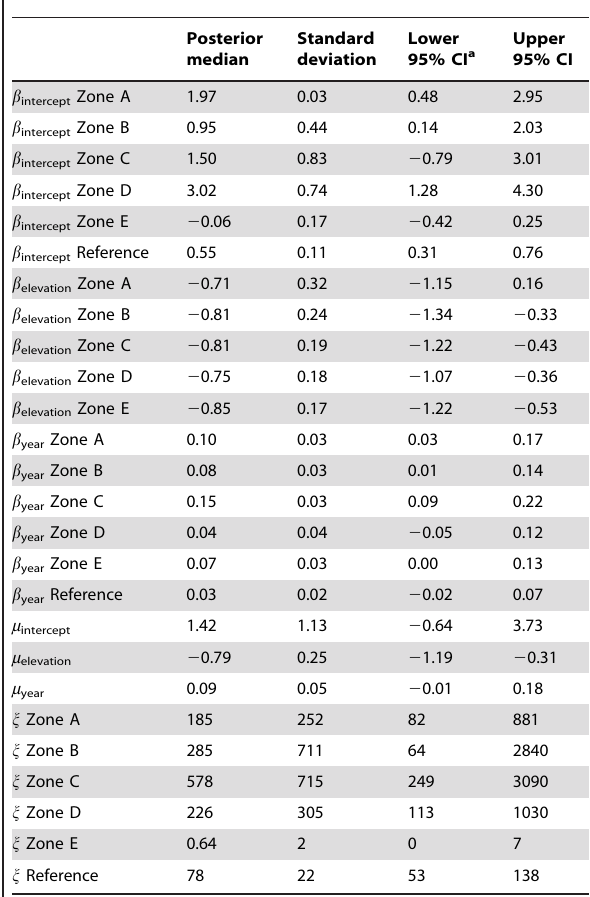
Table 1. Parameter estimates based on 12,000 MCMC samples from posterior densities obtained from a fully spatial hierarchical model (model 4) fit to camas lily monitoring data collected in Weippe Prairie, Idaho, USA and to a reference site in Big Hole National Battlefield, Montana, USA, during